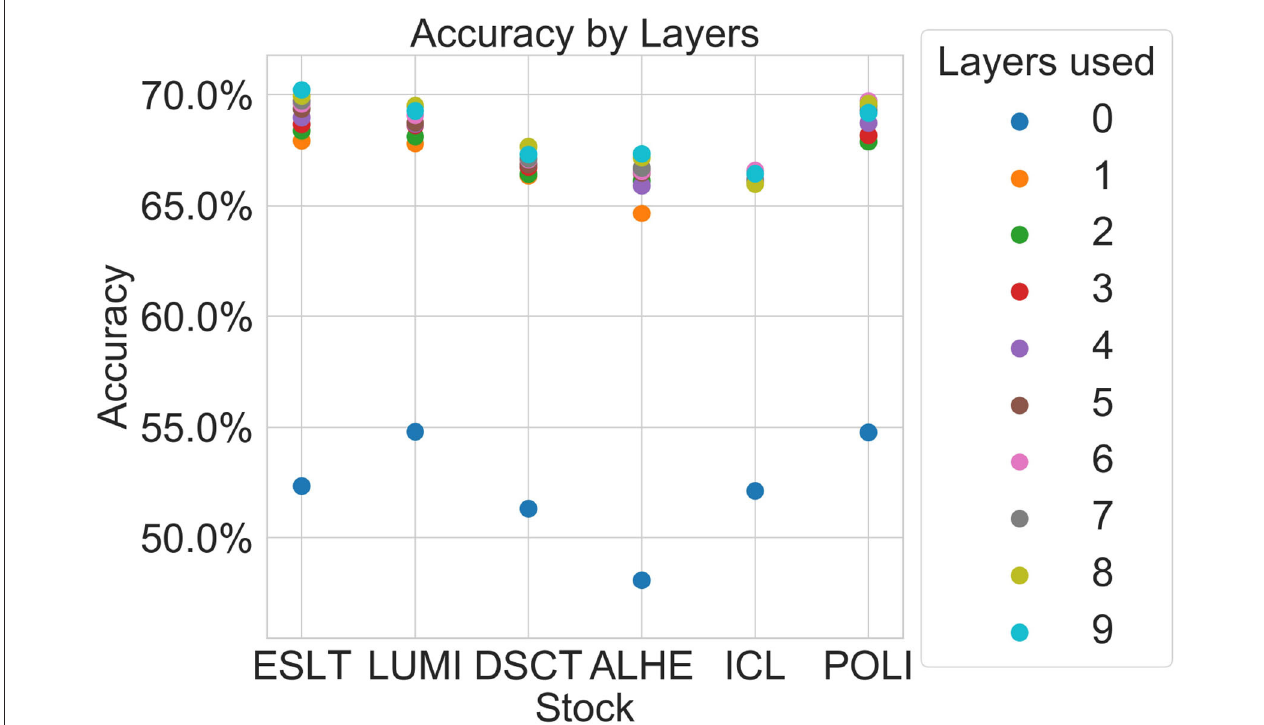
FIGURE 2 | Average prediction accuracy by number of